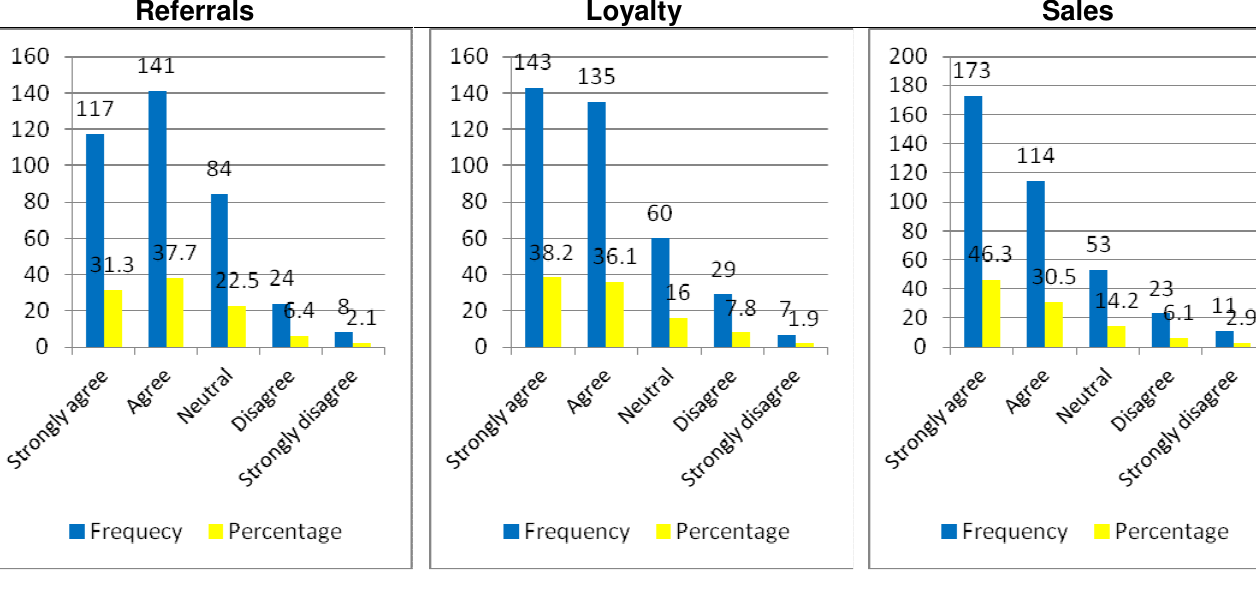
Figure 6: Importance of marketing to referrals, loyalty and sales 69% (31.3 + 37.7) of respondents agree that marketing tools assist them in getting more referrals for their businesses, with 22.5% being neutral. Close to a third of respondents might not be doing any marketing to promote their businesses, but that potentially over 90% could be encouraged to use marketing more effectively. A Chi–square goodness of fit test showed this finding to be statistically significant ( χ 2 = 177.684, df = 4, P = .000). Similarly, 74.3% (38.2 + 36.1) of respondents agree that marketing tools assist them in gaining customer loyalty and 76.8% (46.3 + 30.5) of respondents agree that marketing tools assist them in getting more sales. Chi–square goodness of fit tests showed both the loyalty finding ( χ 2 = 203.059, df = 4, P = .000) and the sales finding ( χ 2 = 246.107, df = 4, P = .000) to be statistically significant. These findings show that respondents generally had a good idea of what marketing could do for their